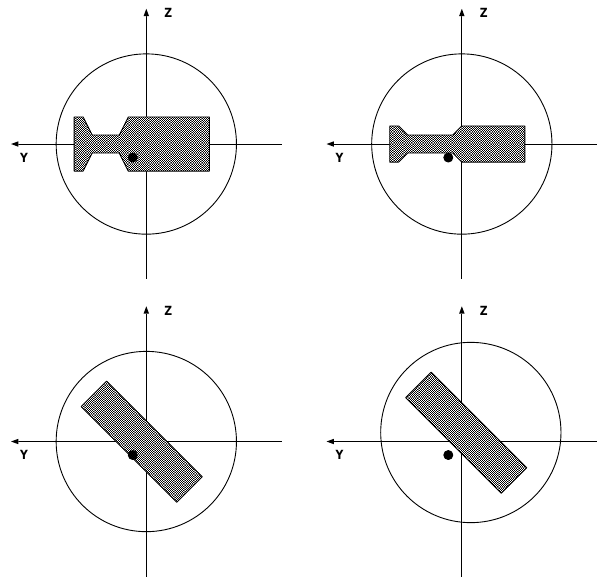
Fig. 17. Schematic tail cross-section showing how Cluster, marked by the black dot, initially inside the plasma sheet (left drawing), ex- periences plasma sheet drop-out as the thin onset region expands to- wards dawn (right drawing). The drawings in the second row show the effect of flapping of the entire tail with a tilted plasma